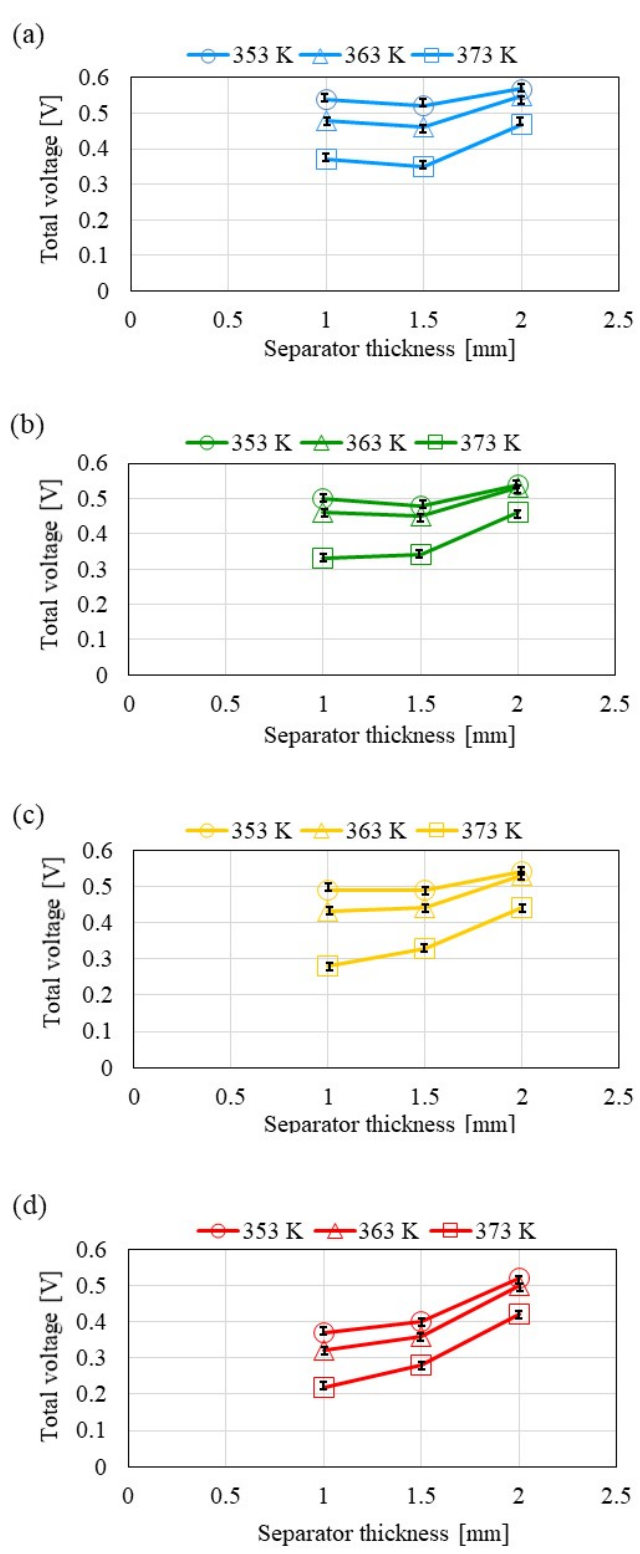
Figure 9. Comparison of the relationship between the separator thickness and total voltage obtained at a current density of 0.80 A/cm 2 with an s.r. of 1.5. This condition was selected to show the in-plane temperature distribution data later, among different T init and RH conditions: ( a ) A80%RH, C80%RH; ( b ) A80%RH, C40%RH; ( c ) A40%RH, C80%RH; ( d ) A40%RH,